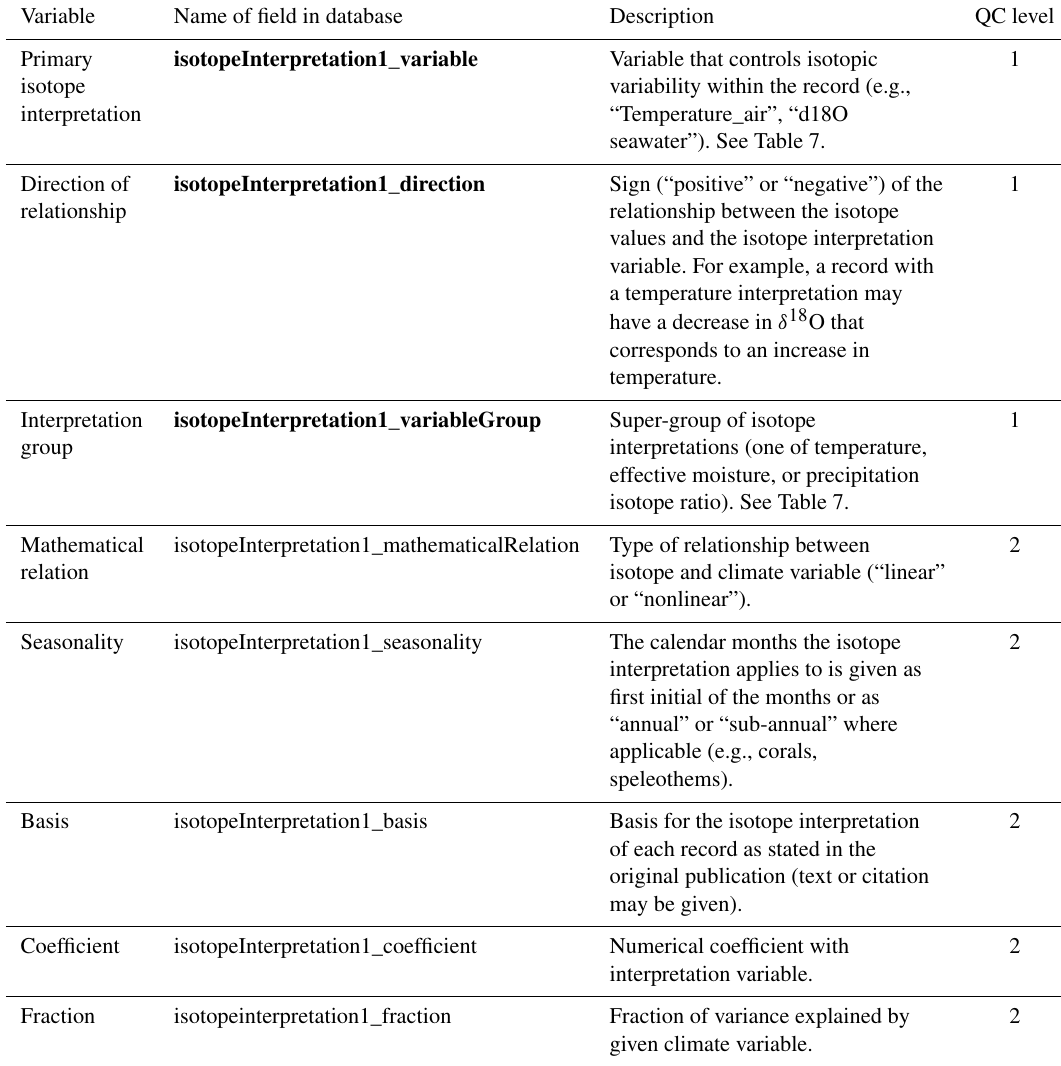
Table 3. Key isotope interpretation metadata. Bold text indicates Level 1 or required fields in the database. Variable Name of field in database Description QC level Primary Variable that controls